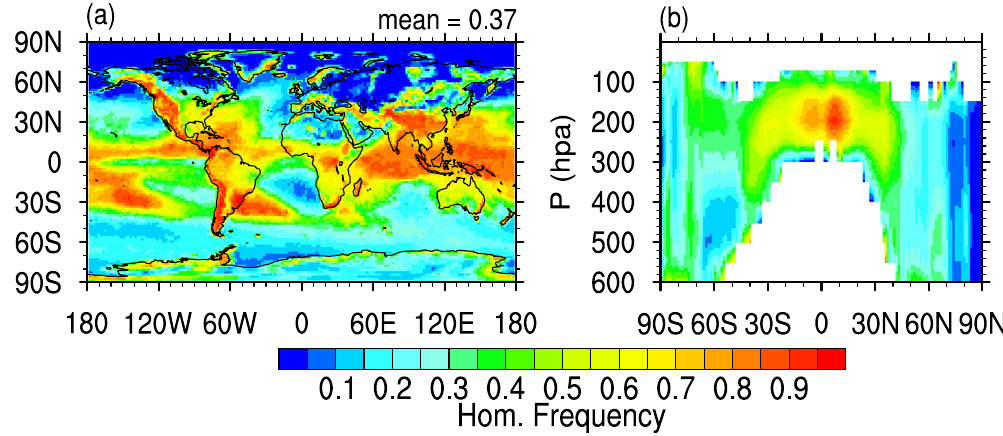
Figure 7. Global distribution of the frequency of cirrus events dominated by homogeneous ice nucleation, vertically weighted by cloud fraction ( a ) and zonal mean ( b ). Maps generated using the NCAR Command Language (Version 6.3.0) Software. (2016). Boulder, Colorado: UCAR/NCAR/CISL/TDD. http://dx.doi. org/10.5065/D6WD3XH5.